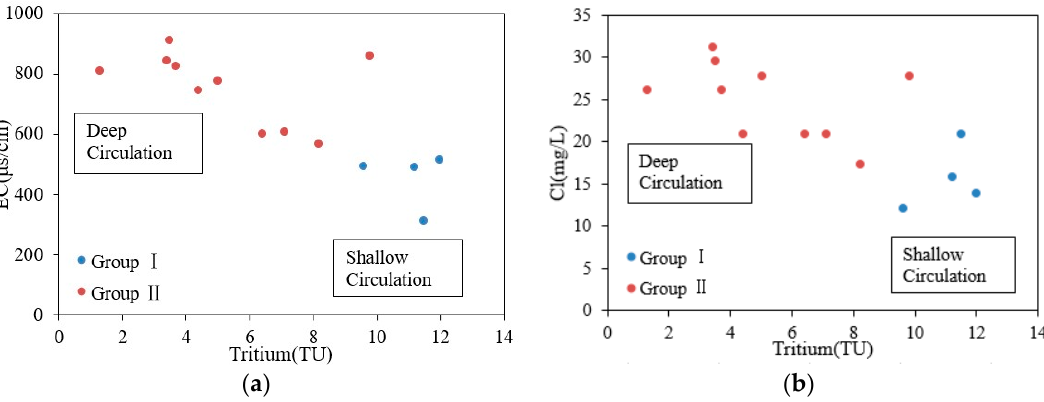
Figure 6. Plots of the tritium contents for water samples against the hydrochemical parameters of ( a ) EC ( μ S/cm) and ( b ) Cl (mg/L). ( a ) EC ( µ S/cm) and ( b ) Cl